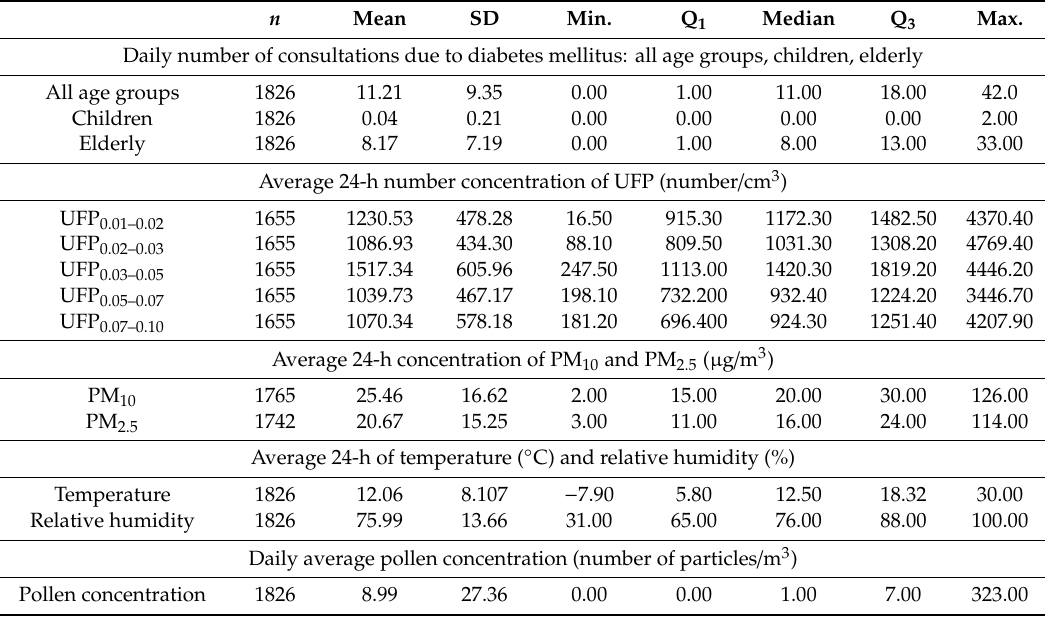
Table 1. Descriptive statistics for the daily number of consultations due to diabetes mellitus and ultrafine, fine, and coarse particulate matter (PM) and meteorological parameters and pollen concentration in the municipality of Ljubljana (MOL), Slovenia between 1 January 2013 and 31 December 2017. n Mean SD Min. Max. Daily number of consultations due to diabetes mellitus: all age groups, children, elderly All age